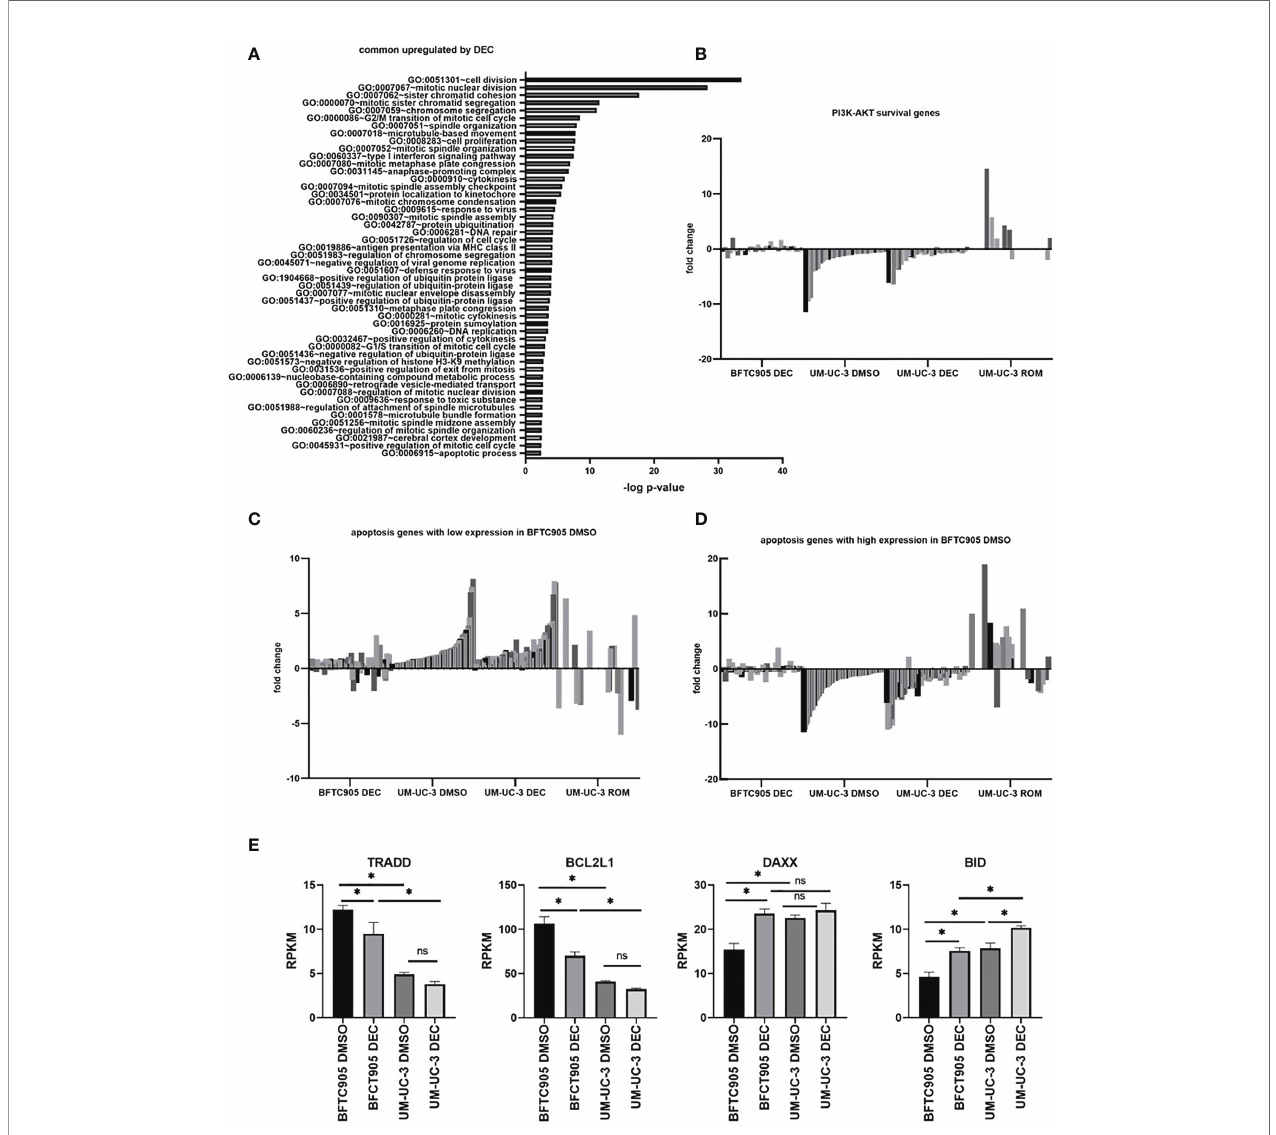
FIGURE 5 | Gene expression changes in UCC BFTC905 and UM-UC-3 after DEC treatment determined by RNA sequencing. (A) GO group analysis was performed for 207 genes commonly induced by DEC in both UCC (d7) using the online tool DAVID (34, 41). Only the GOs with p<0.004 are displayed. (B) Fold change expression of PI3K-AKT survival genes (shades of gray) in indicated samples relative to BFTC905 DMSO used for normalization. Gene lists were downloaded from the Broad Institute GSEA gene sets database (https://www.gsea-msigdb.org/gsea/msigdb/genesets.jsp?collection=CP : KEGG). Genes names and expression values are given in Supplementary Table S6 . (C) Fold change expression of apoptosis genes in indicated samples relative to BFTC905 DMSO. Apoptosis genes with lower expression in BFTC905 DMSO compared to UM-UC-3 DMSO are displayed. See Supplementary Table S7 for gene names and expression values. (D) Fold change expression of apoptosis genes in indicated samples relative to BFTC905 DMSO. Apoptosis genes with higher expression in BFTC905 DMSO compared to UM-UC-3 DMSO are displayed. See Supplementary Table S8 for gene names and expression values. (E) Mean RPKM expression values from RNA sequencing analysis obtained from three replicates are visualized as bar graphs for the four apoptosis regulators that were chosen for further functional analysis by siRNA knockdown. Statistical signi fi cance (p-value <0.05) is denoted by asterisk and was determined by two-way ANOVA and Dunnett ’ s correction for multiple comparisons. ns, not signi fi